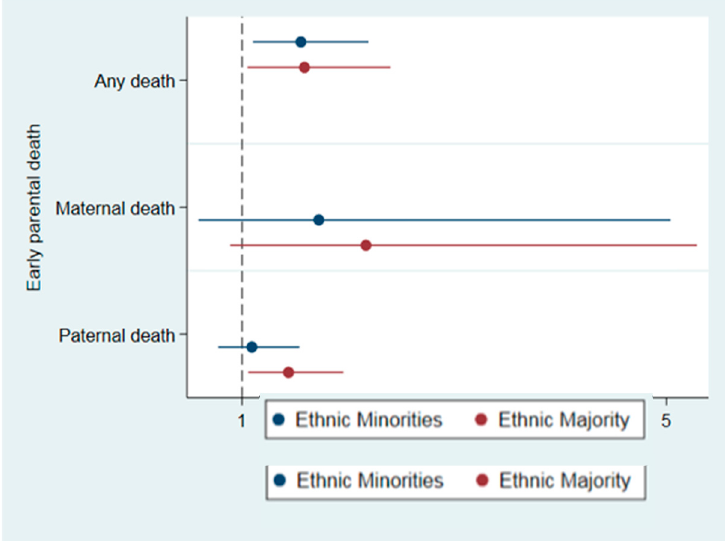
Figure 1. Association between early parental death and odds of psychosis, stratified by ethnic group in the EU-GEI case-control sample. Death of both parents not included due to wide confidence interval with upper-bound value of 28.0.